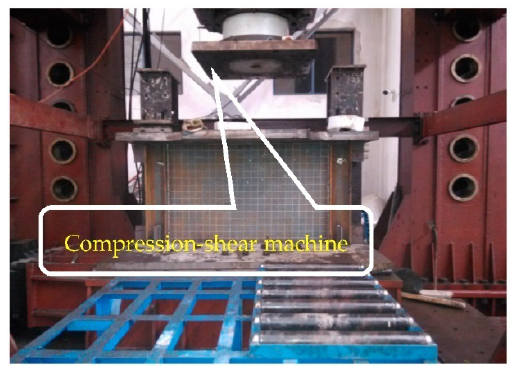
Figure 28. Detailed drawing of installed loading test device for specimen 2.